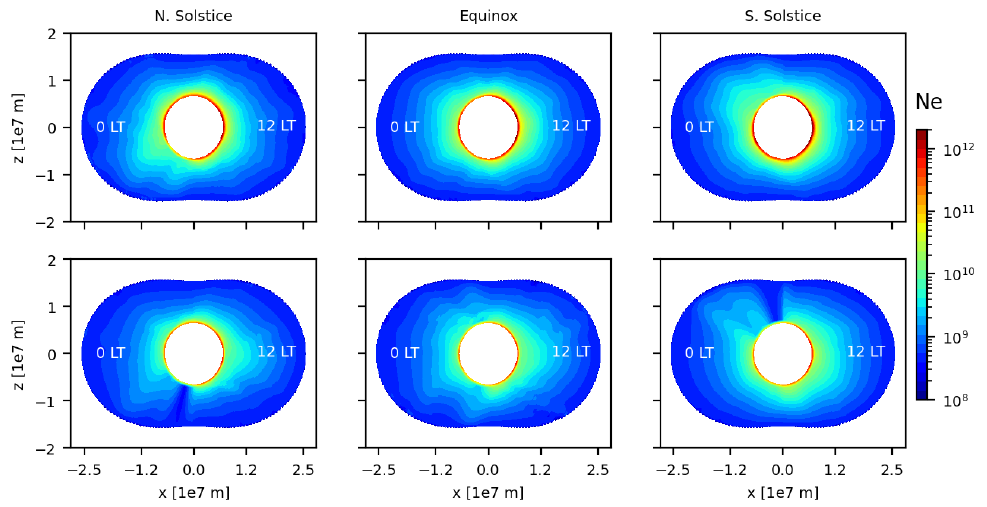
Figure 2. Meridional cross-sections during solstices and equinoxes of 2013 ( top panels ) and 2018 ( bottom panels ). The unit of the color bar is el/m 3